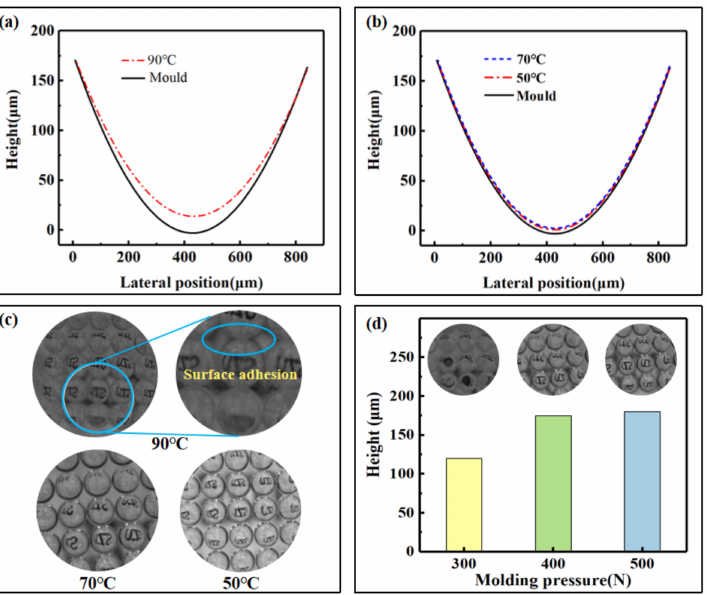
Figure 5. ( a ) Comparison of aspheric lens profile and mold profile when the holding temperature is 90 ◦ C; ( b ) comparison of aspheric lens profile and mold profile when the holding temperature is 70 ◦ C and 50 ◦ C; ( c ) the surface and imaging performance of aspheric microlens at holding temperatures of 90 ◦ C, 70 ◦ C, and 50 ◦ C; and ( d ) the heights and surface morphologies of the aspheric lens under different molding